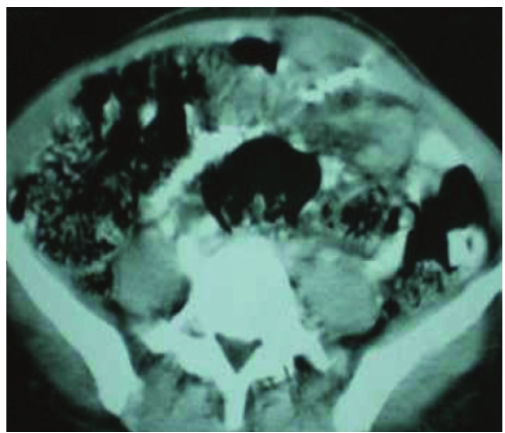
Figure 1: CT scan abdomen showing impacted IUCD.